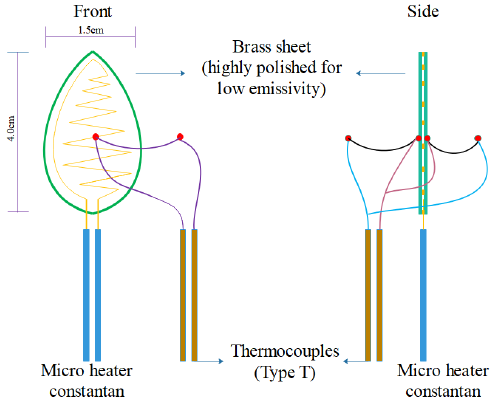
Figure 12. Schematic diagram of thermocouple leaf.